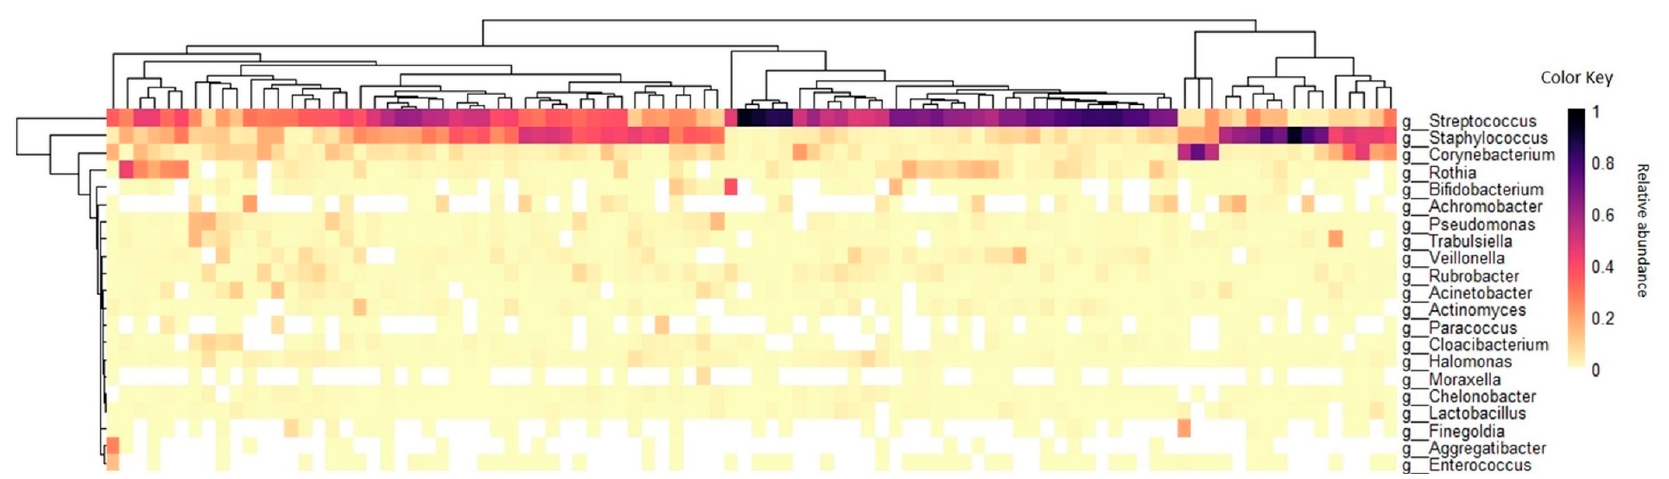
Figure 1. Relative abundance heatmap of the most abundant bacterial genera identified in human milk samples. Legend: The rows present the genera identified in at least 90% of the samples or with maximum relative abundance higher than 0.05. Column represents the milk samples from volunteers at 30 (± 4) days after delivery.